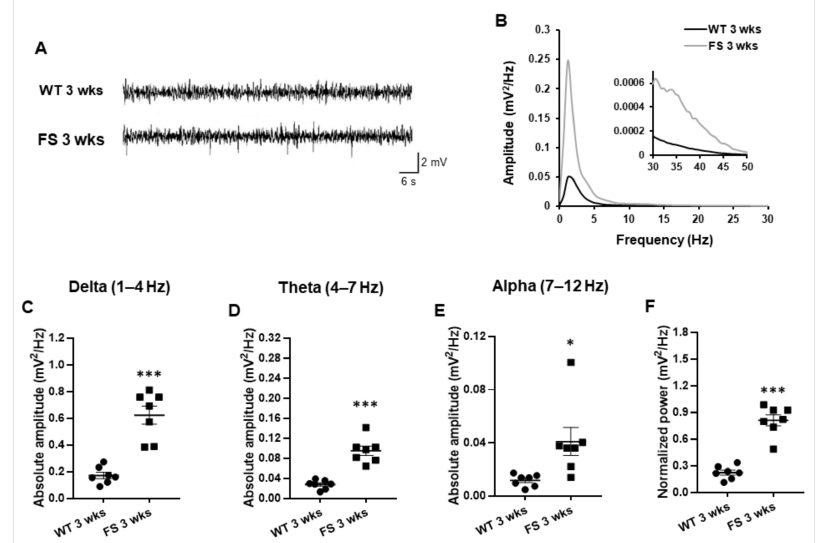
Figure 4. Increased delta and theta oscillations in the hippocampus of FS juvenile rats. Representative LFP traces in the hippocampus of FS 3 weeks rats and wild-type littermate rats ( A ). Power spectral analysis of FS 3 weeks rats revealed larger amplitude at approximately 1–5 Hz frequency than wild-type 3 weeks rats ( B ). Neuronal activities of FS 3 weeks rats at delta ( C ), theta ( D ), and alpha frequency waves ( E ) were markedly elevated in comparison with those of wild-type littermate rats. Representative power spectral analysis showed that averaged and normalized amplitude power of FS 3 weeks rats were stronger than those of wild-type rats after 3 weeks ( F ). Data are presented as means ± standard errors of the mean. * p < 0.05, *** p < 0.001, two-tailed t -test (WT 3 weeks, n = 7; FS 3 weeks, n = 7).